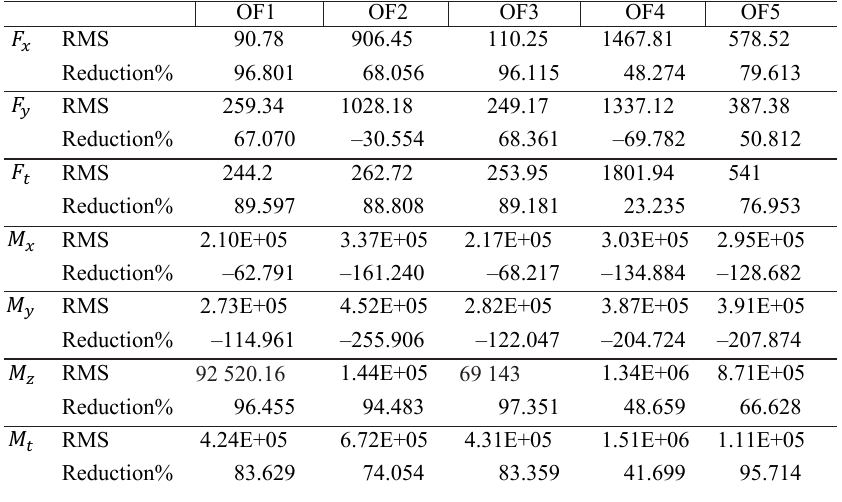
Table 5. RMS and reduction %